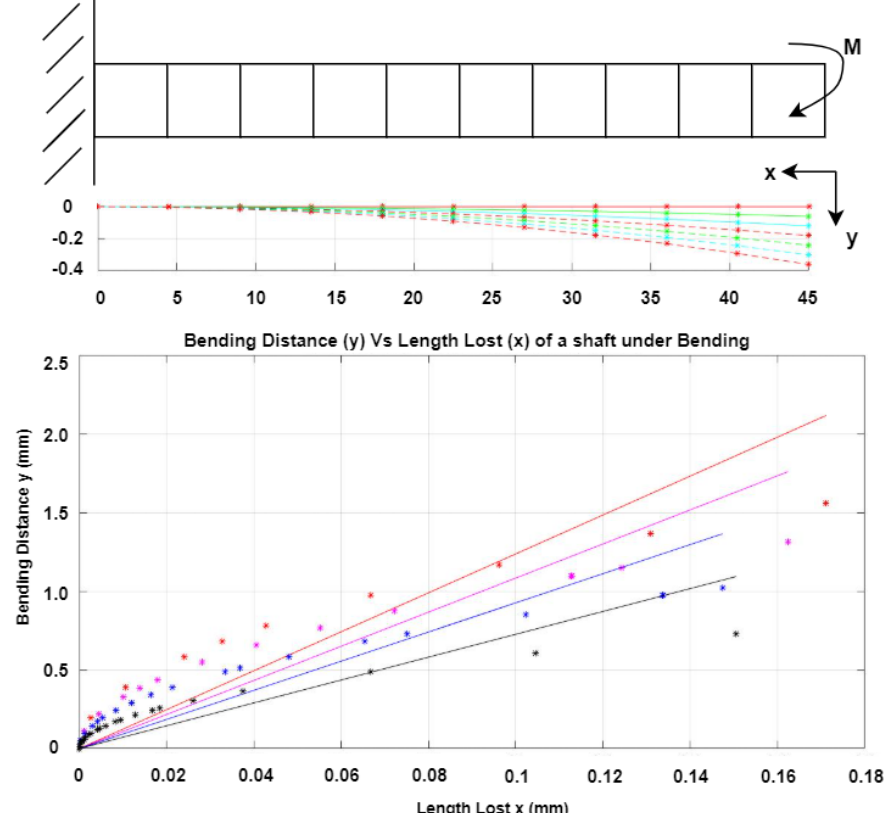
Figure 12. Top : Segmented model with each segment considered a stiff shaft with no deformation and 2D simulation. Bottom : scatter plot of vertical displacement due to bending(y) and length reduction horizontally (x). Regression lines: Beam length 180 cm (Red), 135 cm (Magenta), 90 cm (Blue), and 45 cm